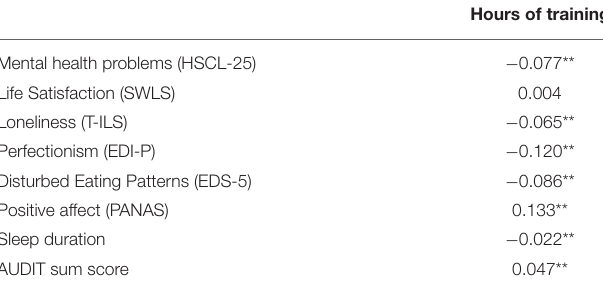
TABLE 2 | Pearson correlation coefficient between hours of training and instruments (continuous) assessing mental health problems.